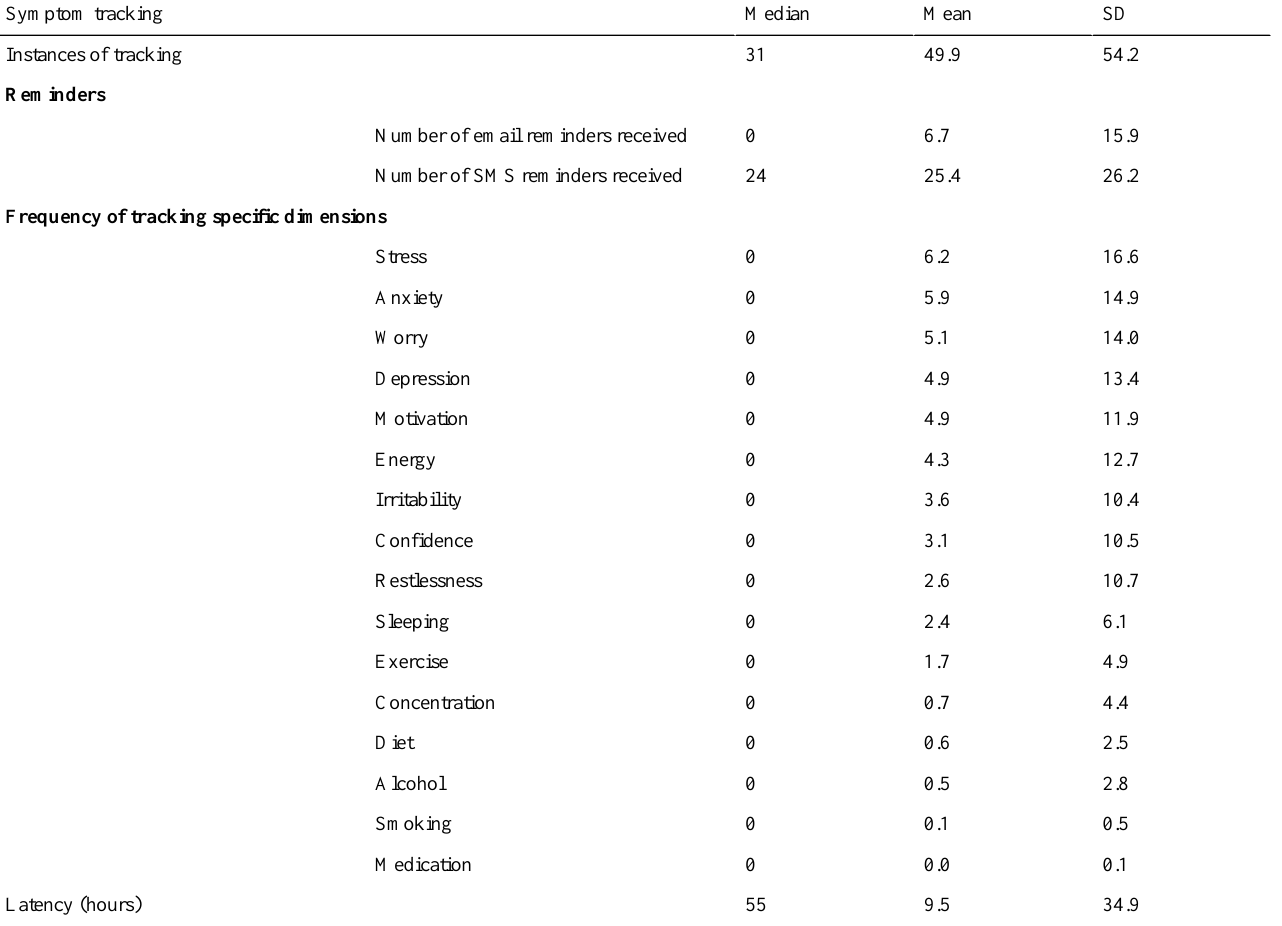
Table 2. Symptom tracking usage statistics